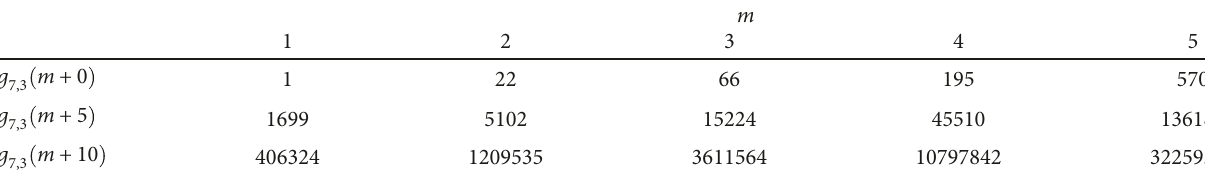
n sequence for n ≤ 15 . 7,3